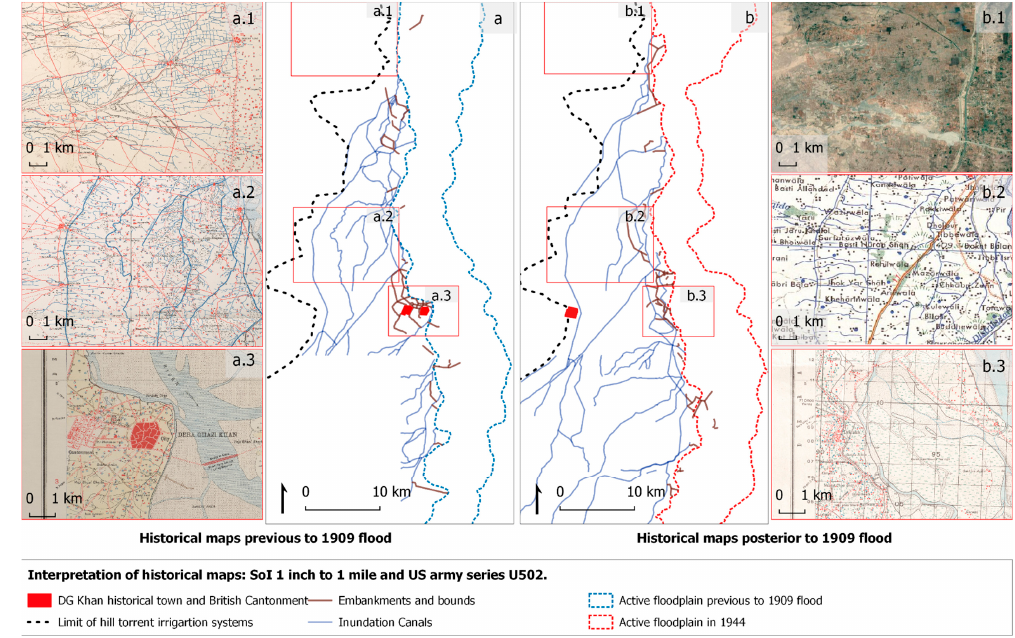
Figure 2. General overview of the AOI before ( a ) and after ( b ) the 1909 flood, according to the information contained in the SoI 1” to 1-mile maps (for more details see Section 3 and Figure 5). The maps contain information of the historical landscape morphology: ( a.1 & b.1 ) irrigation systems based on hill-torrents; ( a.2 & b.2 ) inundation canals in the old floodplain; ( a.3 & b.3 ) active floodplain, earthworks and canals around DG Khan. No maps edited before the flood were available for the South-West sector of the AOI (see Figure 5). SoI maps Image courtesy of UL, Cambridge.